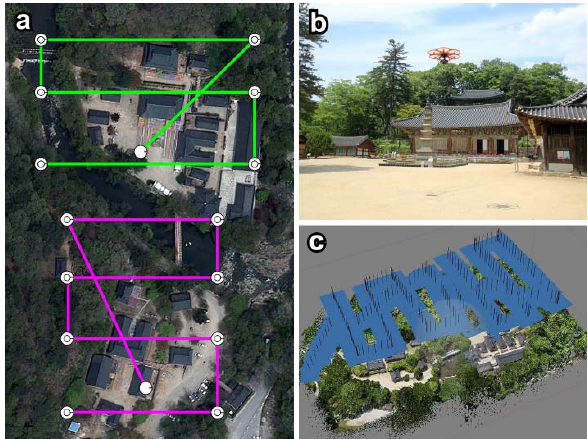
Figure 5. Process of UAV photogrammetry used to map the Magoksa Temple: (a) Flight plan; (b) Image of the flying UAV; (c) Photography